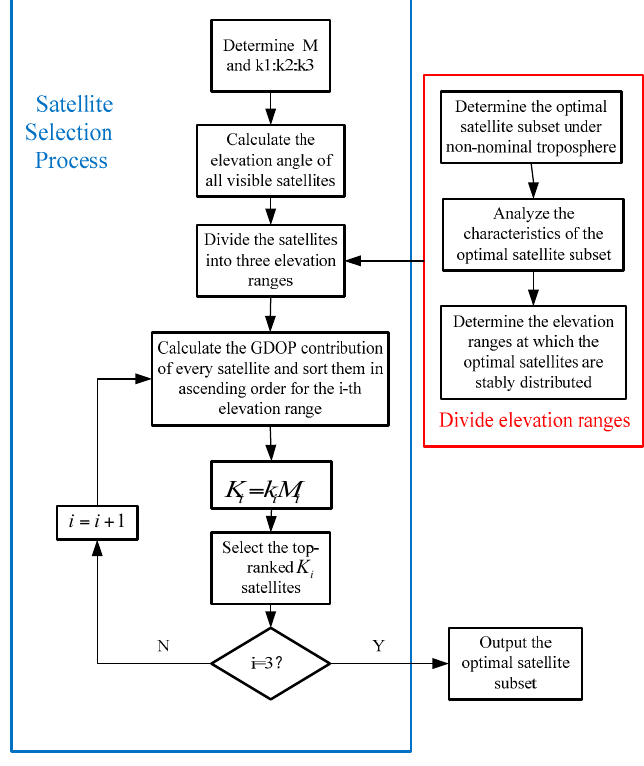
Figure 16. Processing flow of the proposed new method.